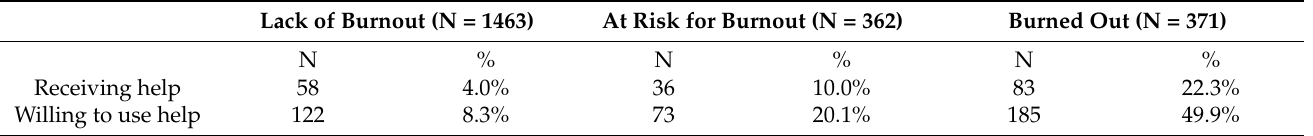
Table 7. Percentage of people using professional help and those willing to use help now (psycho- logical, psychiatric, support group) because of the COVID-19 pandemic by level of burnout (N = 2196).